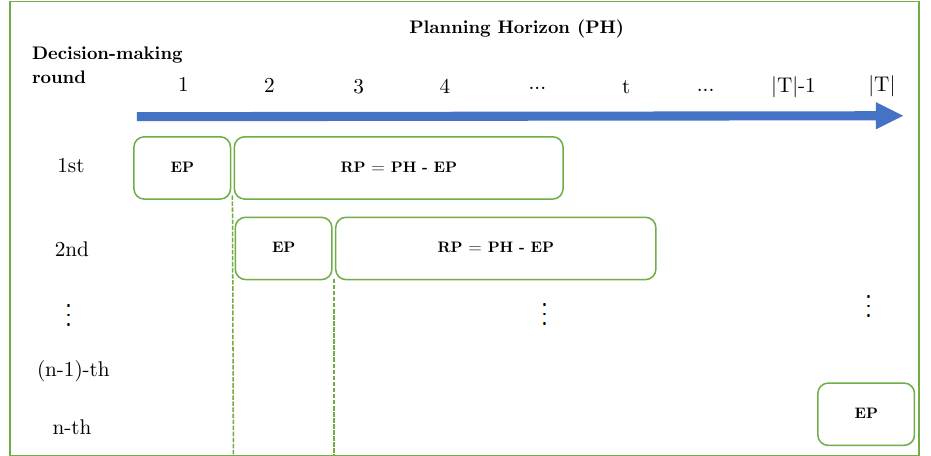
Figure 1. Diagram of a dynamic decision-making